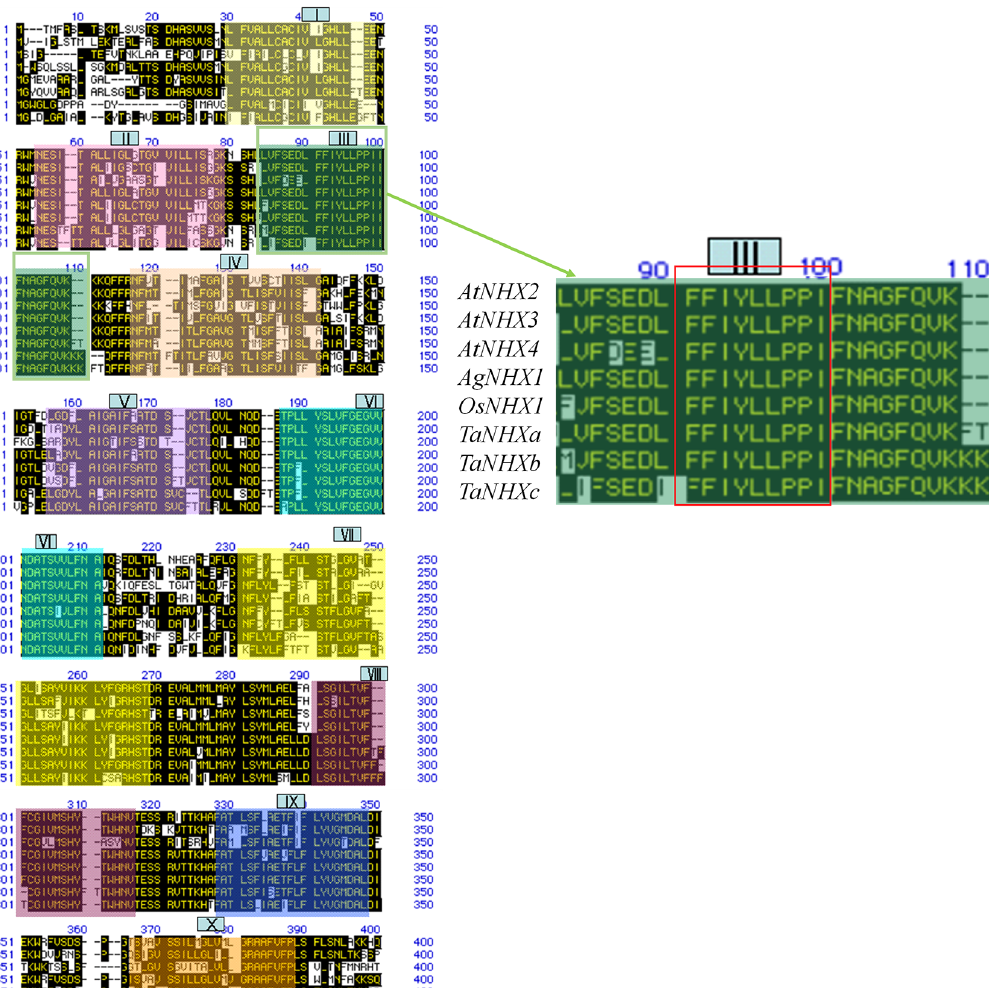
Figure 1 – Deduced amino acid sequences of wheat Na + /H + antiporter-like transcripts. To conduct cloning of Na + /H + antiporter genes expressed in bread wheat, primers were designed by finding similar common regions in OsNHX1 of rice and AgNHX1 of Atriplex subcordata . After spraying young plants of the bread wheat variety Chinese Spring with 0.5 M NaCl, RNA was extracted. Three kinds of 1,392~1,400 bp cDNA were isolated by RT-PCR using primers designed from the cell vacuole-type Na + /H + antiporter genes of rice and Atriplex subcordata . In addition, tip ends of the cDNA were obtained with the RACE method and the total structures determined by using primers based on the nucleotide sequence of cDNA clones of TaNHXa , b , and c . Three vacuolar-type antiporter-like genes, TaNHXa , b , and c , encoding 539~547 sequences of amino acid residues with 12 transmembrane domains containing amyloid binding sites, a characteristic of the vacuolar-type Na + /H + antiporter, were isolated from bread wheat. The total lengths of TaNHXa , b and c were 2,414 bp, 539 a.a. (GenBank accession